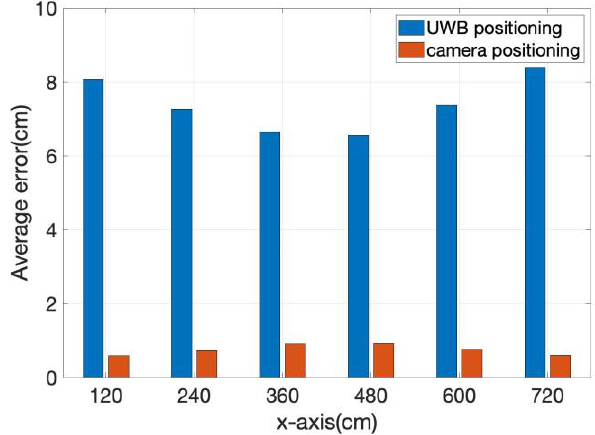
Figure 10. Average errors of two localization methods.